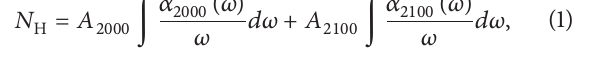
and hydrogen content 𝐶 H